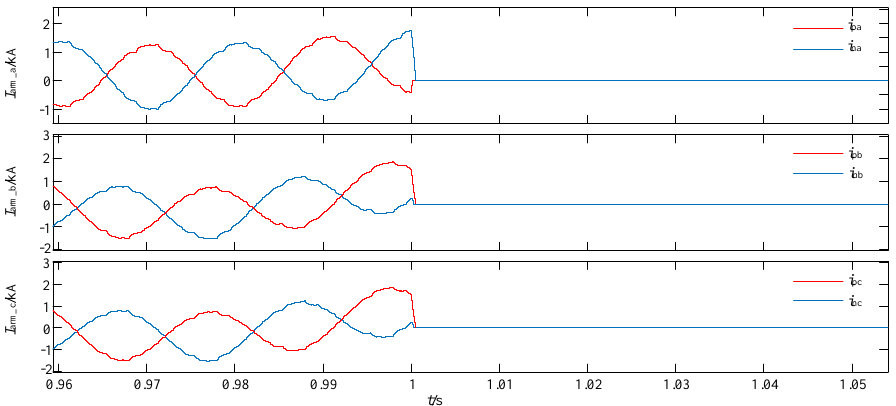
Figure 11. Bridge arm current waveform.